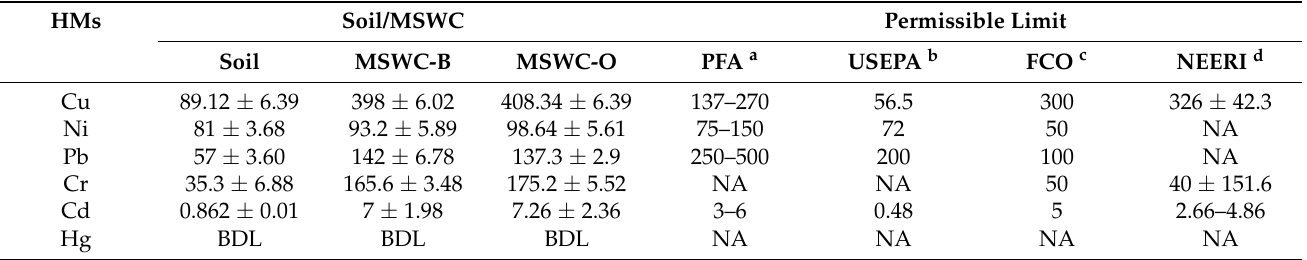
Table 4. Heavy metal contents and standards of control soils and MSWCs used in the experiment (mg kg − 1 ).